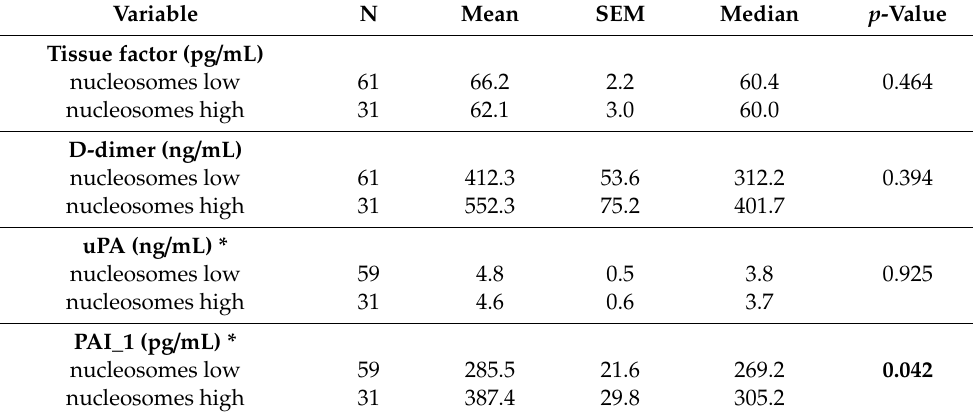
Table 4. Association between nucleosomes and